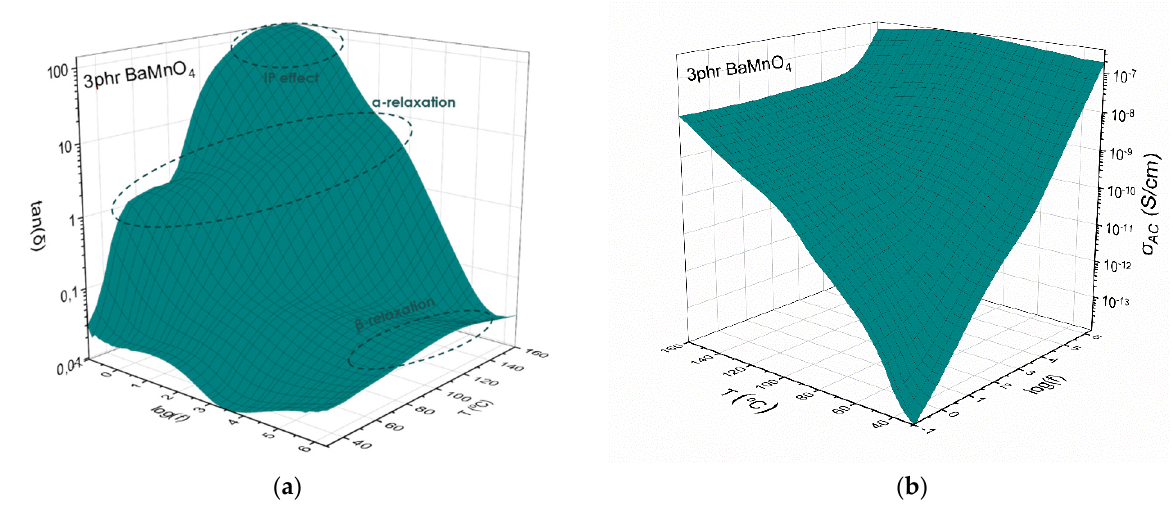
Figure 2. Dielectric spectra of the 3 phr BaMnO 4 nanocomposite as a function of temperature and frequency for ( a ) loss tangent—tan( δ ) and ( b ) AC conductivity ( σ AC ).